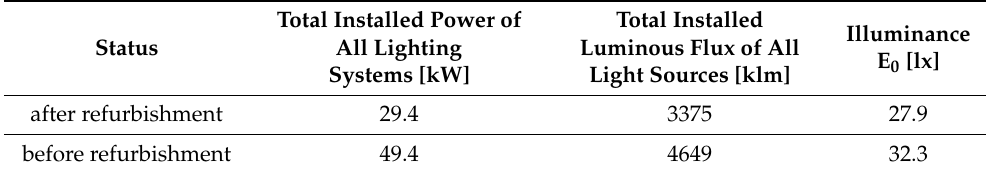
Table 2. Comparison of key parameters of the model of lighting installation in TR Prosenice before and after refurbishment.